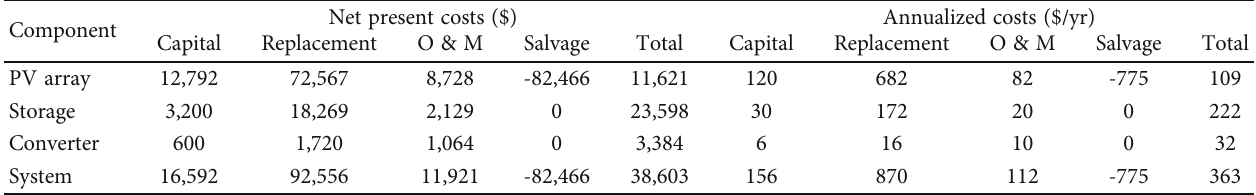
Table 5: Present worth and annualized value of all costs over 30 years.